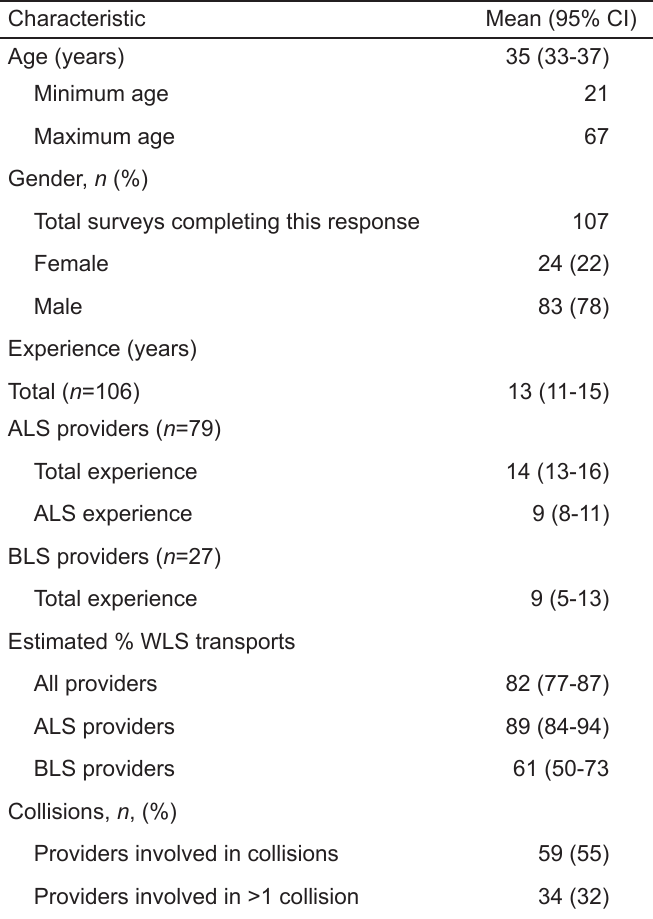
Table 1. Characteristics of emergency medical services responders to a survey on the use of lights and siren.